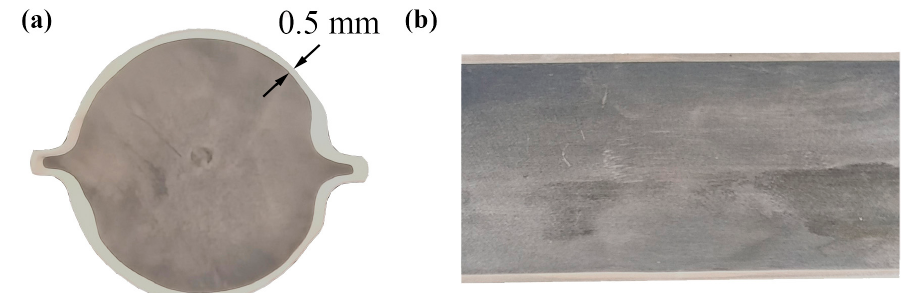
Figure 8. Images of the end face and axis of the clad rebar: ( a ) end face; ( b ) axis